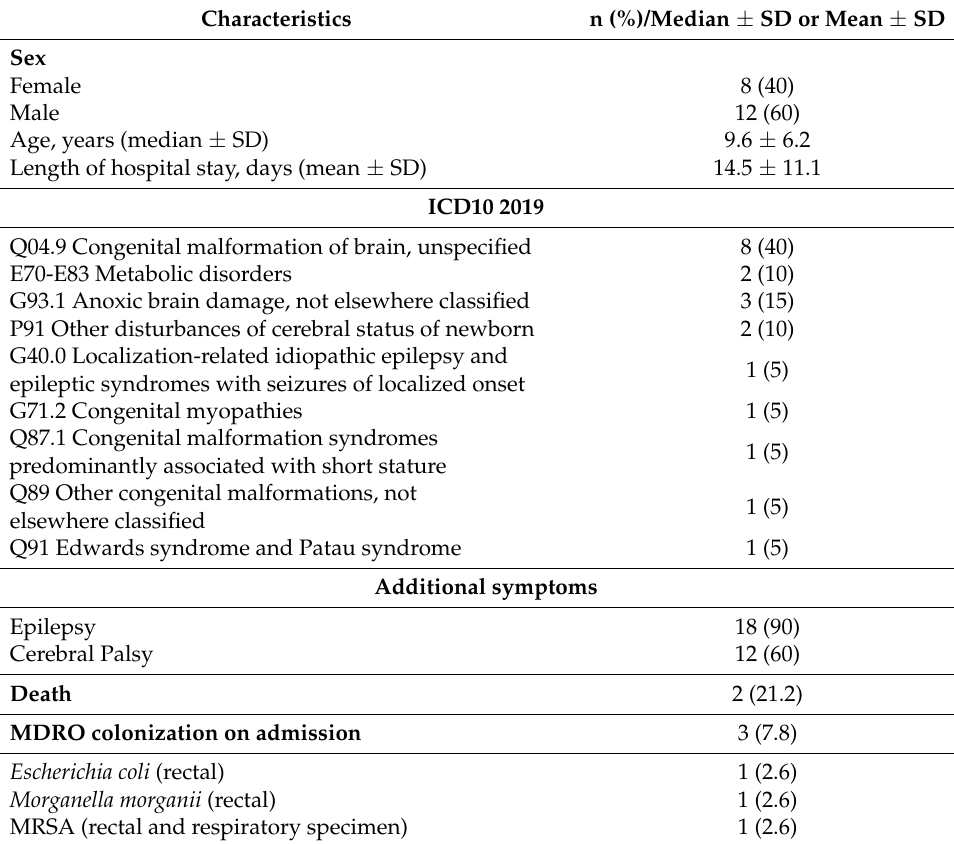
Table 1. Clinical characteristics of the included patients ( n = 20).